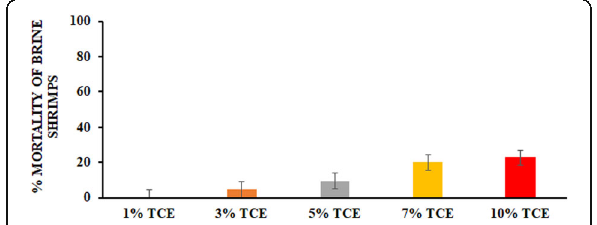
Fig. 5 Percentage mortality of brine shrimps after 24 hours of exposure to the TCE